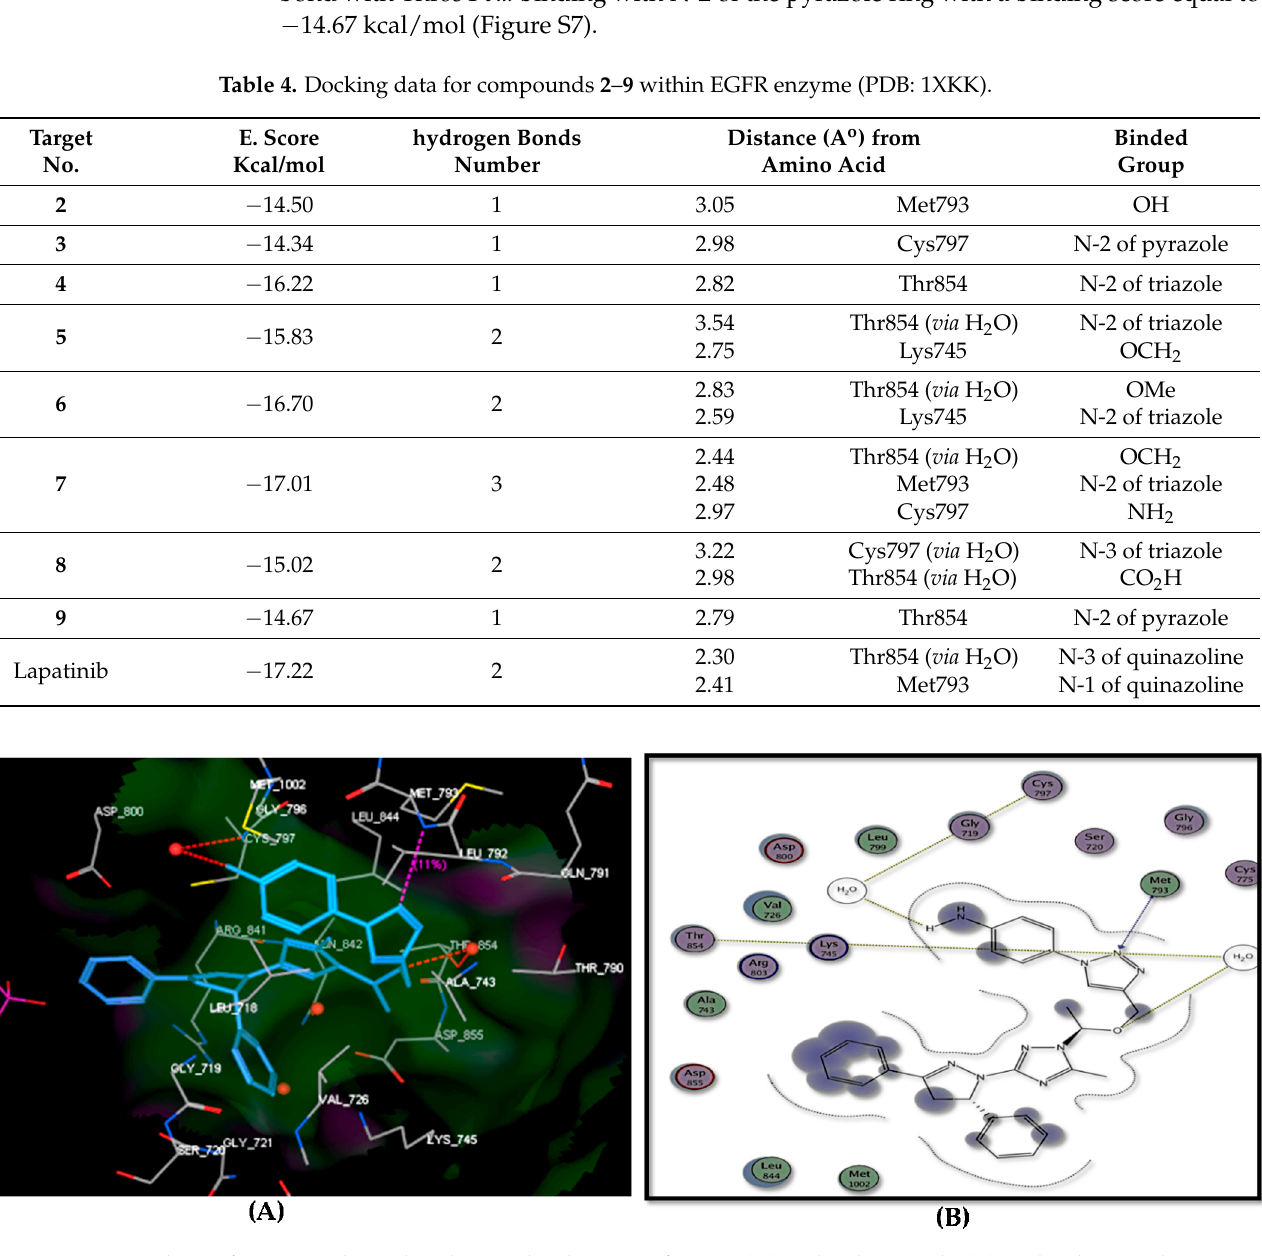
Figure 6. Docking of compound 7 within the ATP binding site of EGFR: ( A ) 3D binding mode; ( B ) 2D binding